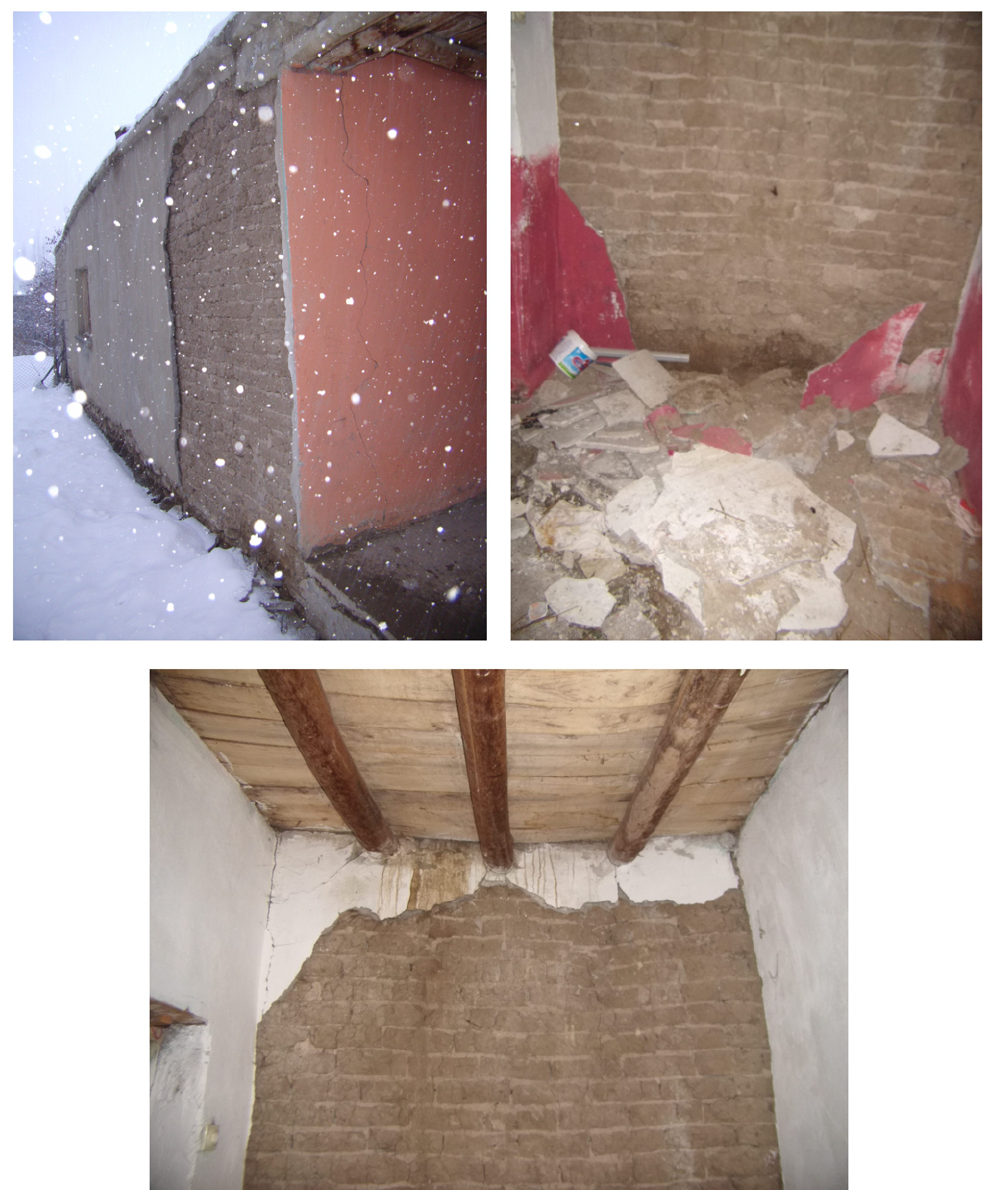
Fig. 19. The exterior and the interior plaster spalling at the adobe